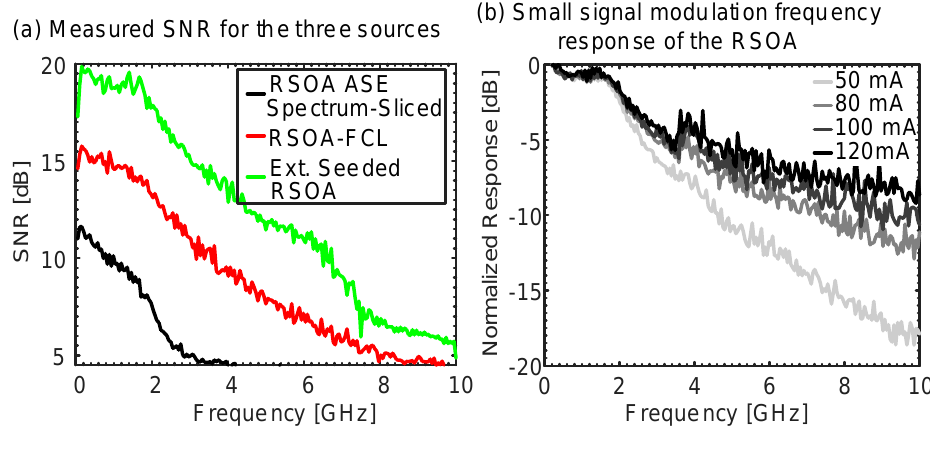
Figure 13. Measured SNR and small signal frequency response: ( a ) Measured signal-to-noise ratio (SNR) vs. frequency for the RSOA ASE spectrum-sliced, self-seeded RSOA-FCL and externally seeded RSOA colorless transmitters driven at 100 mA; ( b ) Small signal modulation frequency response of an RSOA at different bias